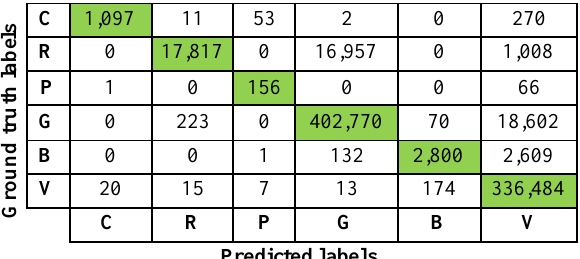
Table 2. Multi-class confusion matrix for classification results achieved in MT 2 (green cells represent the number of true positive per each